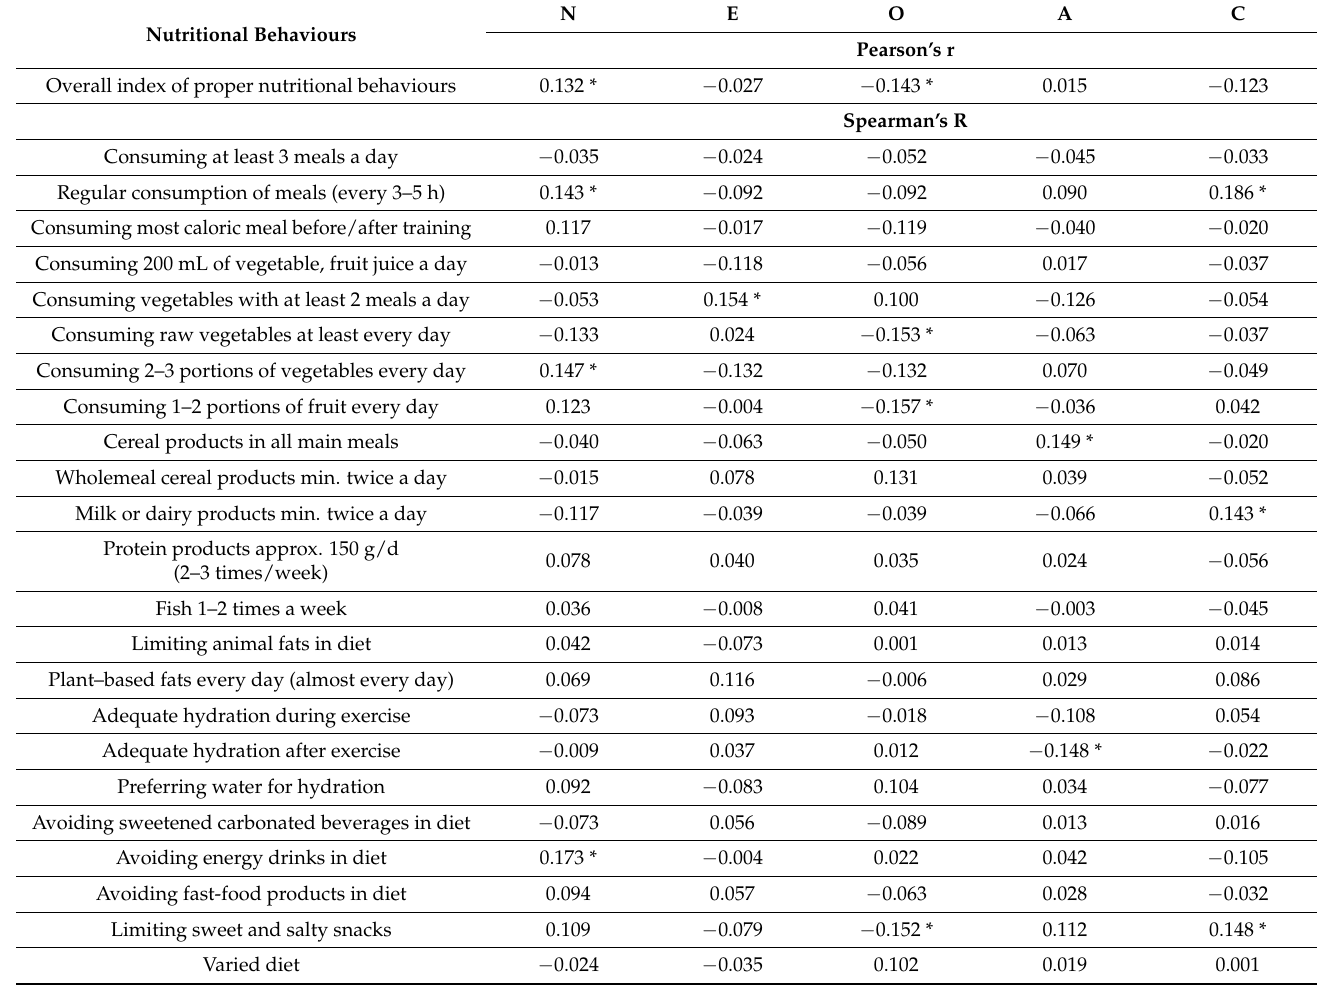
Table 4. Relationships between personality traits and the overall index of proper nutritional be- haviours and the implementation of individual recommendations of the Swiss pyramid among athletes training in team sports (analysis of Pearson’s and Spearman’s R correlation coefficients).